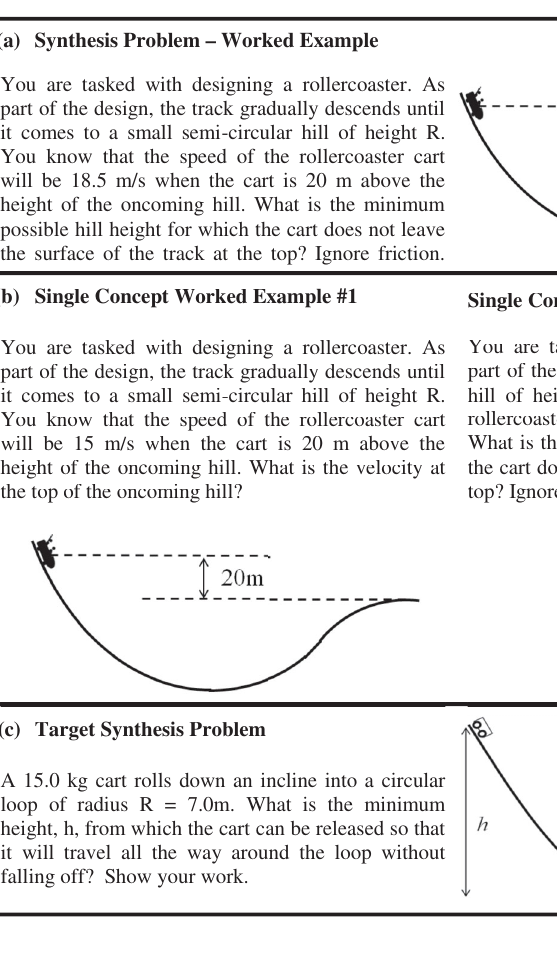
FIG. 2. An example synthesis worked example (a), the corresponding single concept worked examples (b), and the target synthesis problem